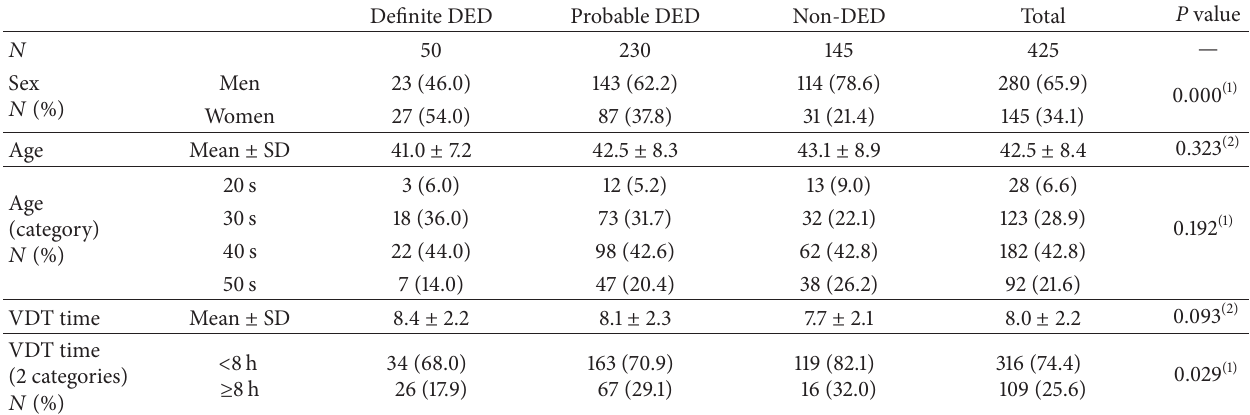
Table 1: Characteristics of the study participants who completed dry eye disease examinations and a physical activity questionnaire.